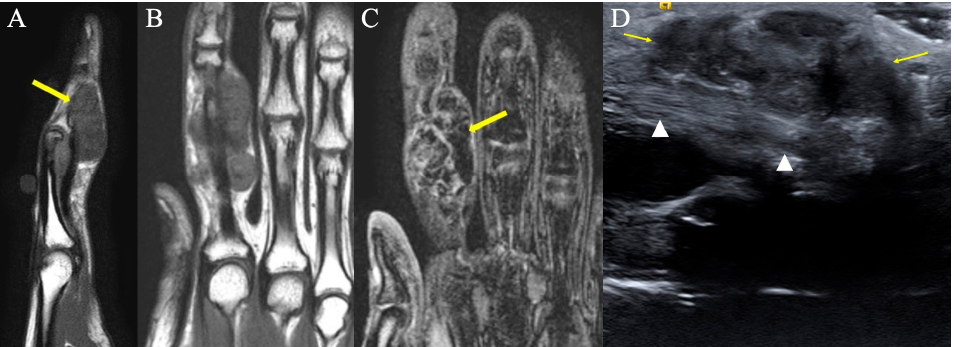
Figure 4. Representative images of tenosynovial giant-cell tumors of tendon sheath, previously known as PVNS. ( A ) Sagittal T1-weighted image showing a volar hypointense homogenous mass at the level of the PIP joint. ( B ) Coronal T1-weighted image demonstrating a hypointense homogenous mass on the ulnar aspect of the index finger, consistent with TGCT of tendon sheath. ( C ) Gradient-echo coronal image of the hand demonstrating a hypointense mass of the index finger with associated distorted artifact signal (yellow arrow), so called “blooming” artifacts consistent with TGCT of tendon sheath. This characteristic appearance is secondary to intralesional hemorrhage and hemosiderin deposition; because hemosiderin includes paramagnetic Fe+3 atoms, the local magnetic field around areas of hemosiderin deposition become distorted. ( D ) Longitudinal ultrasound of the index finger shows the palmar component of the tenosynovial giant ‐ cell tumor as a hypoechoic lobular mass (arrows), volar to the flexor tendon (arrowheads). The diagnosis was proven by ultrasound ‐ guided percutaneous needle biopsy.